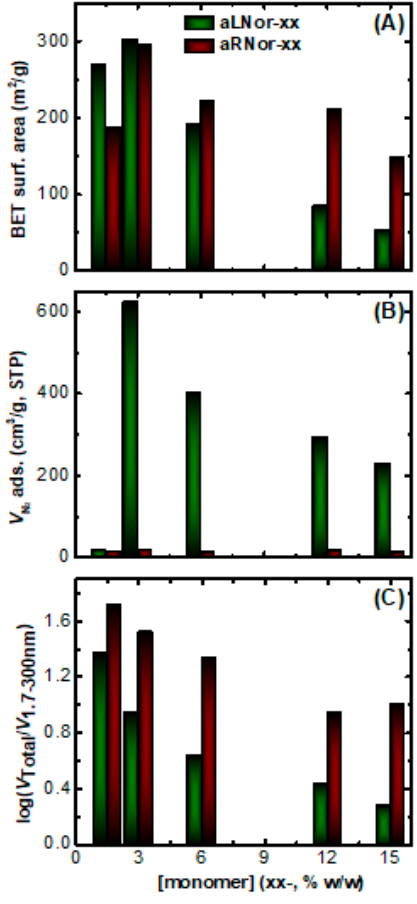
Figure 12. Comparative diagrams for data from N 2 -sorption porosimetry: BET surface area ( A ), total volume of N 2 adsorbed ( B ), and V Total / V 1.7–300 nm ratio ( C ).